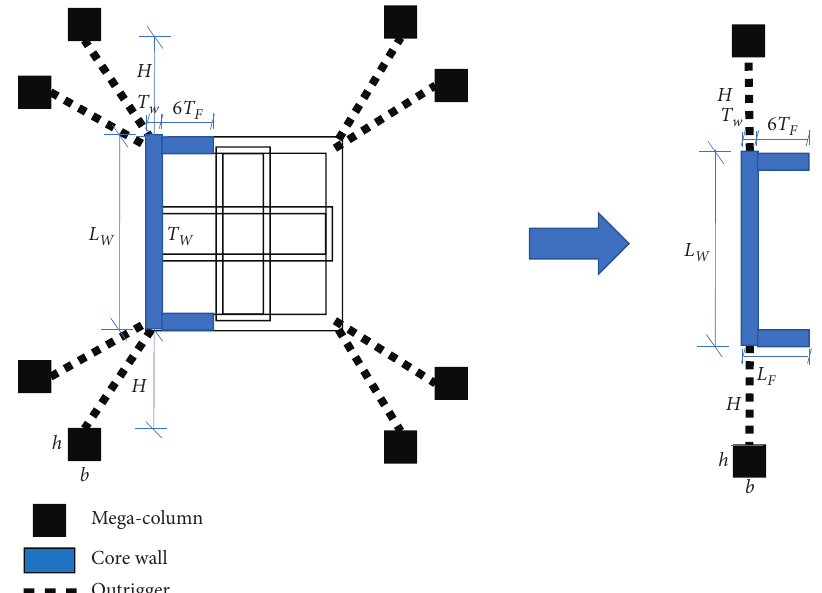
Figure 4: Simplified method for the wall and column elements.